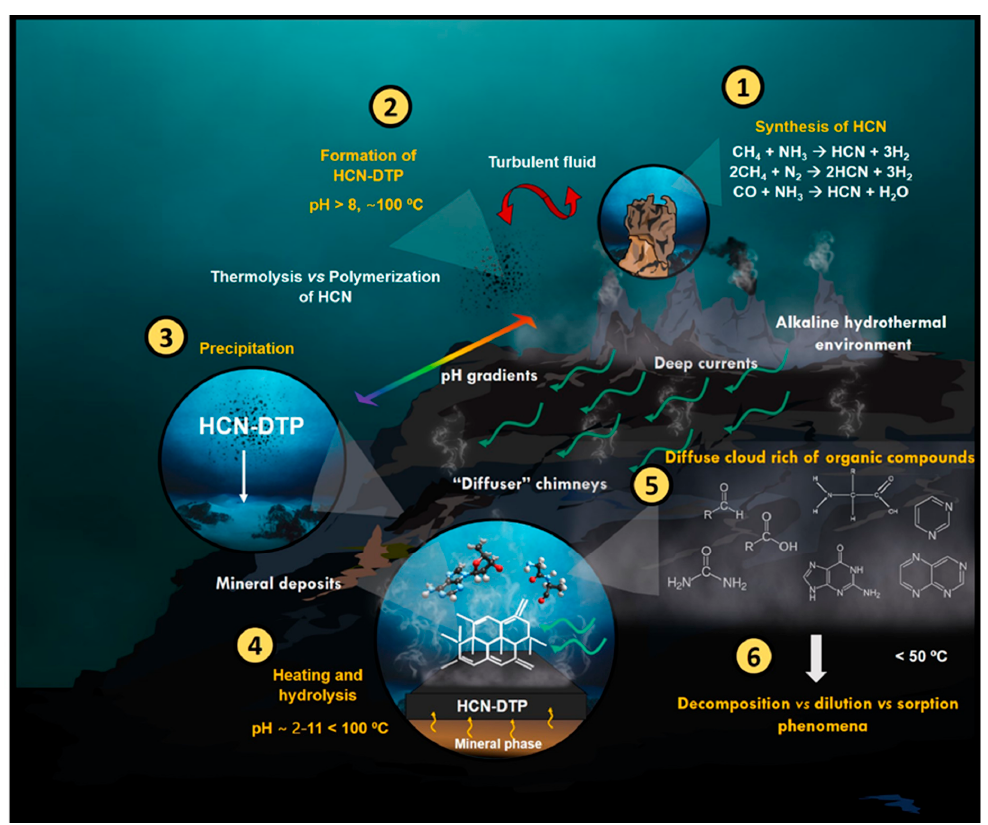
Figure 5. Probable fate of HCN and its thermal polymer (HCN-DTP) in a primitive submarine hydrothermal system. Each point is described in detail in the text.